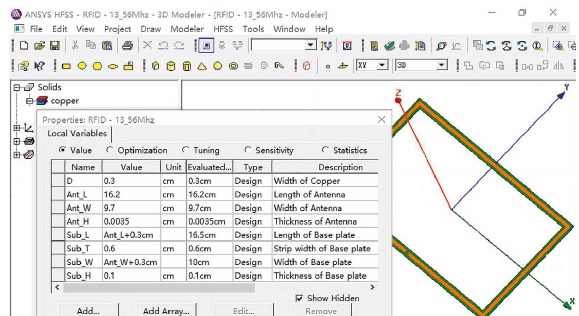
Figure 8: HFSS used to design the antenna coil on the 7-inch LCD.